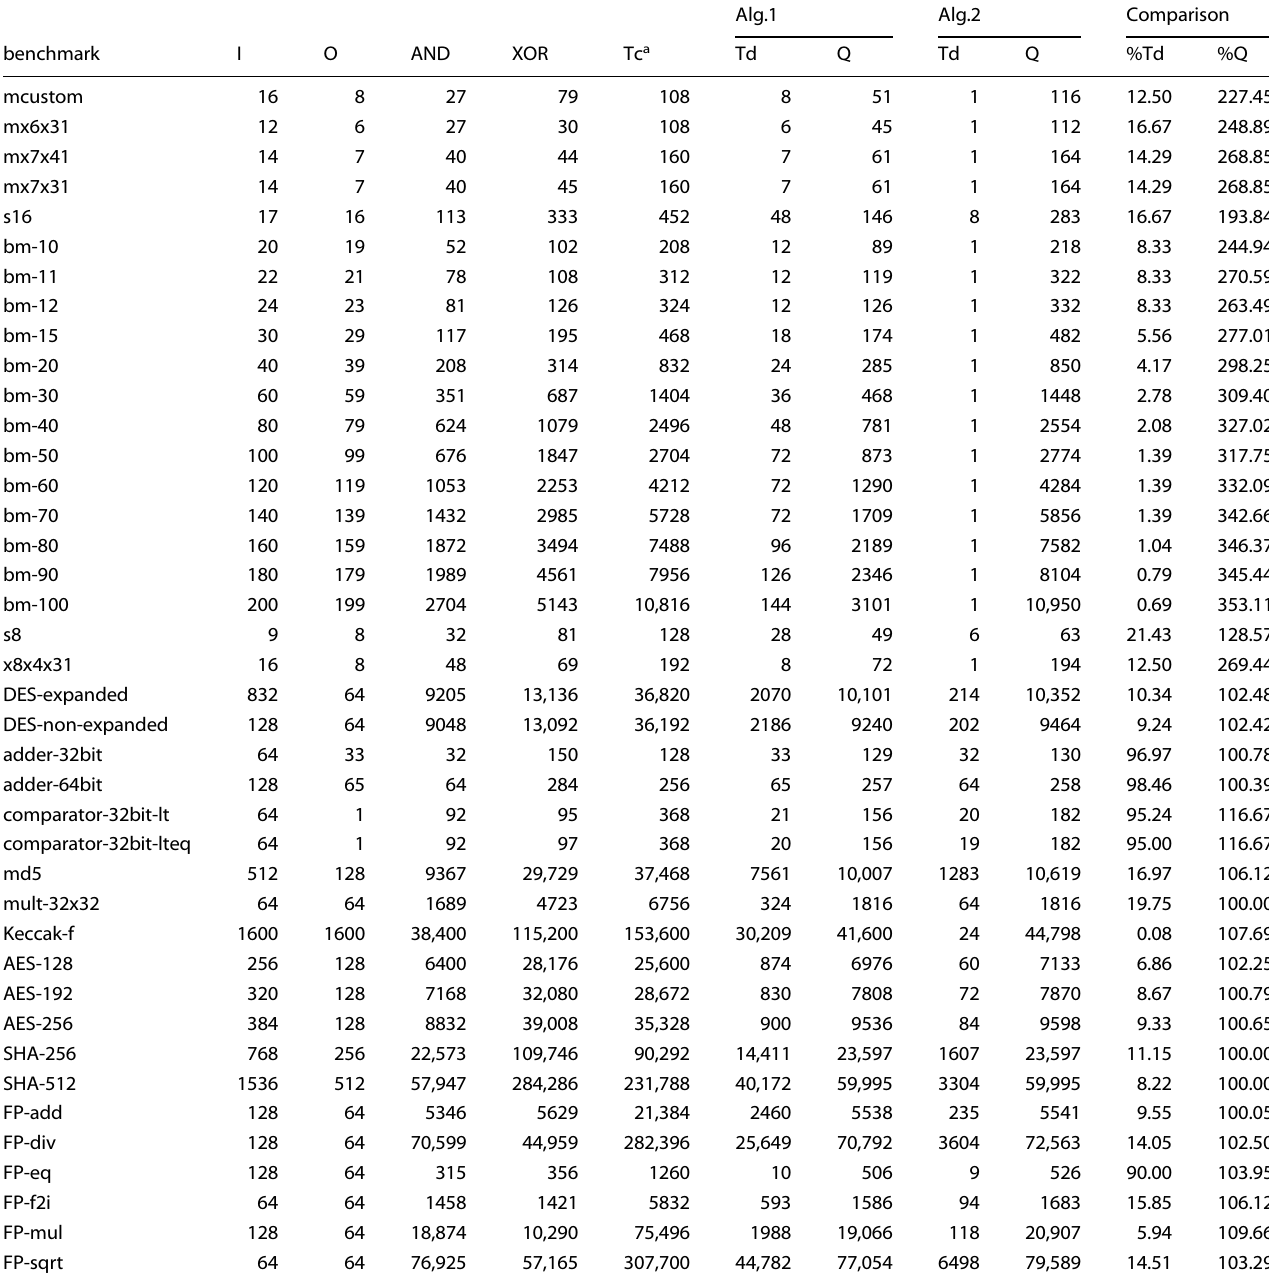
Table 1. Compilation results.